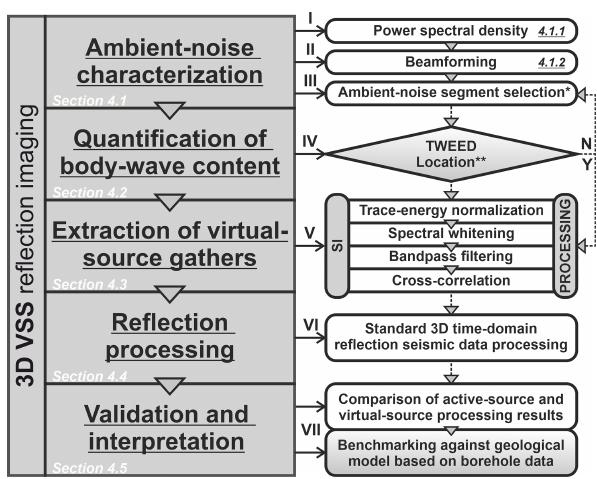
Figure 2. Summary of the 3D virtual-source survey methodology for the purpose of near-mine mineral exploration. The left column presents the core of the flowchart: it contains five main process- ing blocks representing Sect. 4.1–4.5. The detailed processing steps performed within each main processing block are shown in the right column. The sequence of processing is indicated by roman numer- als. Gray-gradient-colored blocks in the right column indicate our modifications of the state-of-the-art ambient noise imaging work- flow proposed by Draganov et al. (2013). The single star symbol denotes the user-dependent “ambient noise segment selection” pro- cessing step, in which the initial selection is based on the beamform- ing results and later verified by TWEED. The double star symbol denotes the location procedure, which supports the TWEED verifi- cation but is not